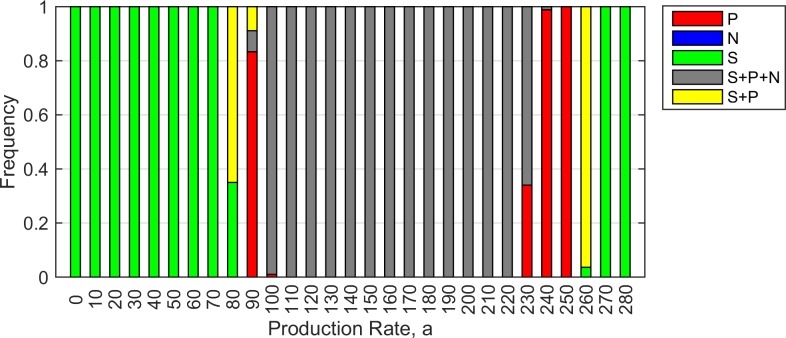
Possible outcomes of 100 simulation trials for each value of production rate a.Green–S only; red–P only; grey–S, P and N; yellow–S and P. Parameters: r1 = 2, r2 = 2.5, v = 1, b = 10, c = 0.001, δt = 0.01.